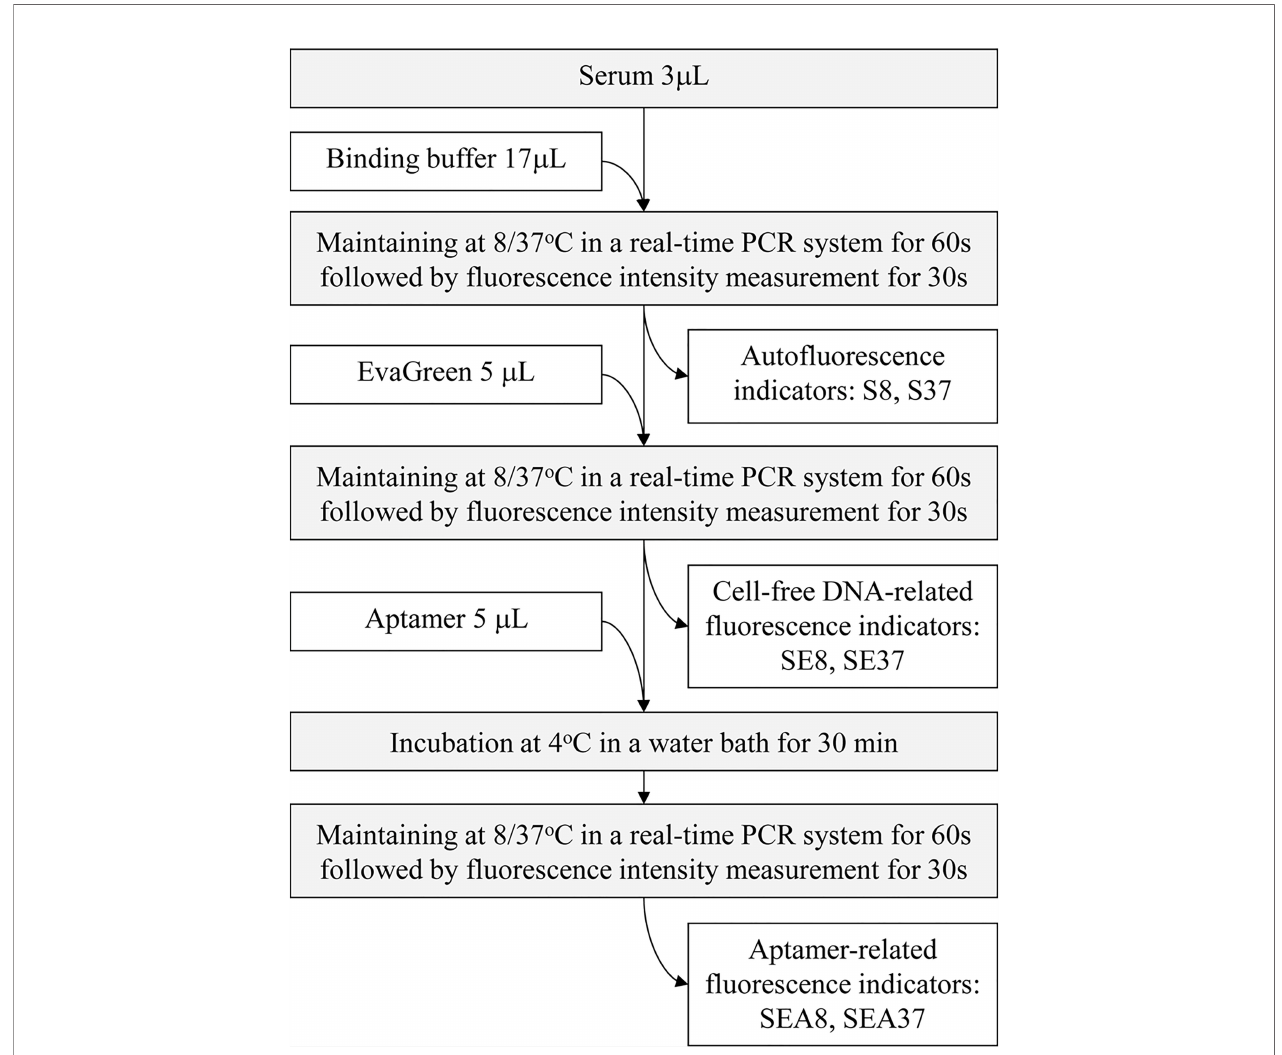
FIGURE 2 | Diagram of the measurement of aptamer-based triple serum fl uorescence intensities. S8, S37, SE8, SE37, SEA8 and SEA37: the names of 6 original fl uorescence indicators, in which the abbreviations indicate serum (S), EvaGreen (E), aptamer (A), 8°C (8) or 37°C